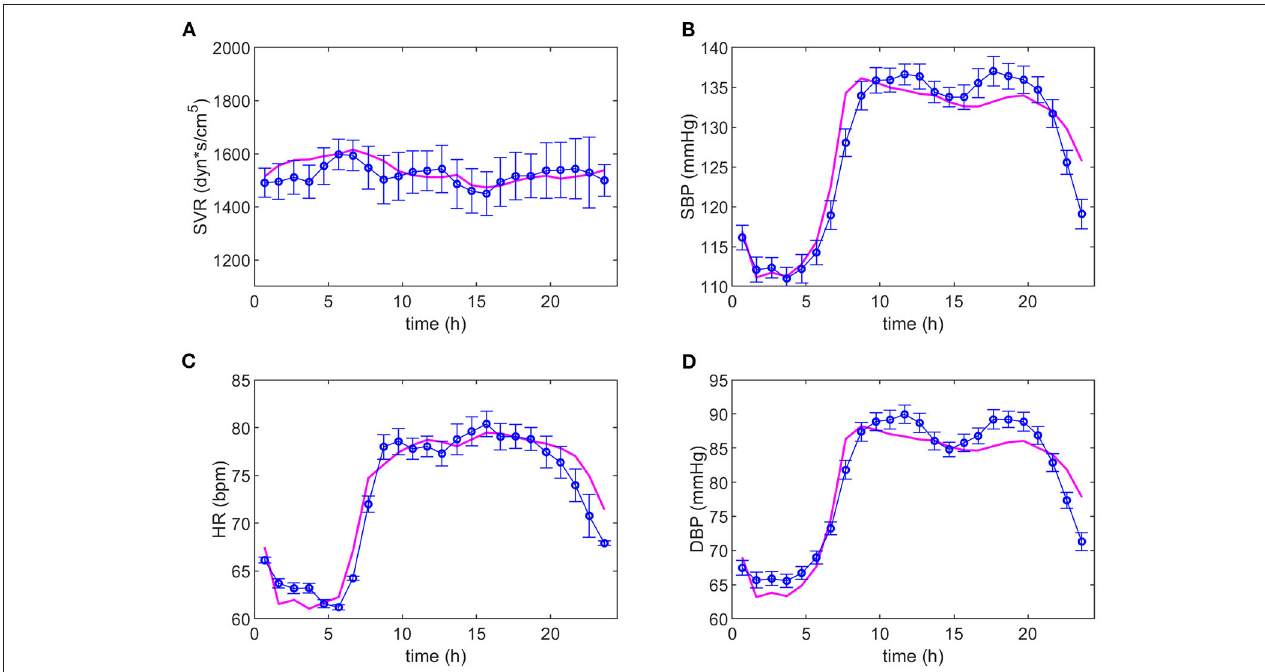
FIGURE 2 | Adjustment of the model to the experimental data of dipper subjects. The magenta line represents the values predicted by the model and the blue line, the experimental data with their respective standard deviations. Dynamics of systemic vascular resistance (SVR), systolic blood pressure (SBP), heart rate (HR), and diastolic blood pressure (DBP) are presented in (A–D) , respectively.